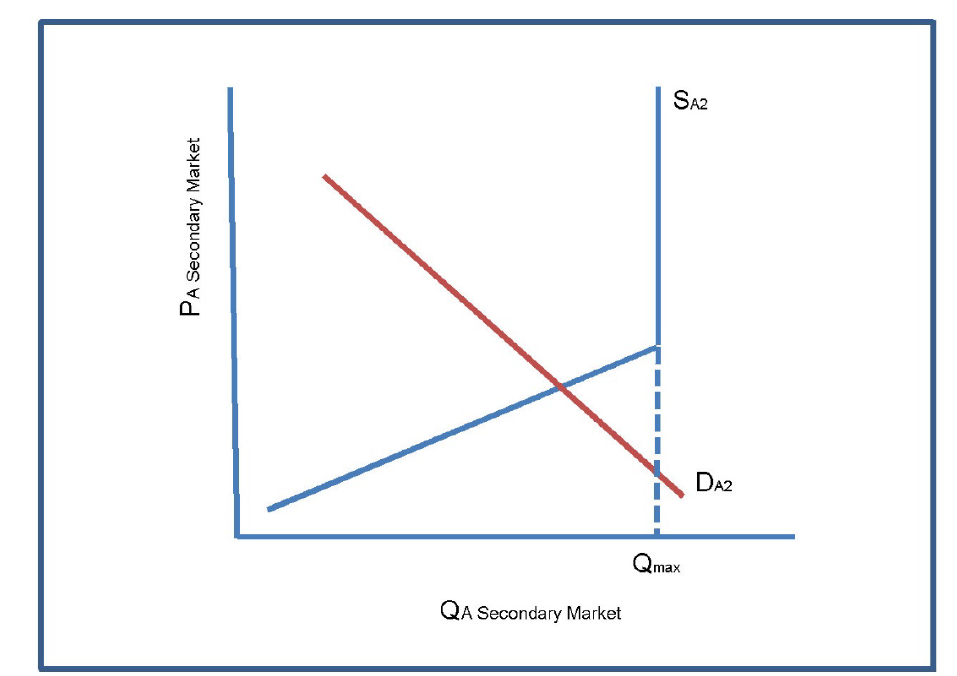
FIGURE 1: Demand and Supply relationship for 'Fine Art' in the secondary market. Source: Authors’